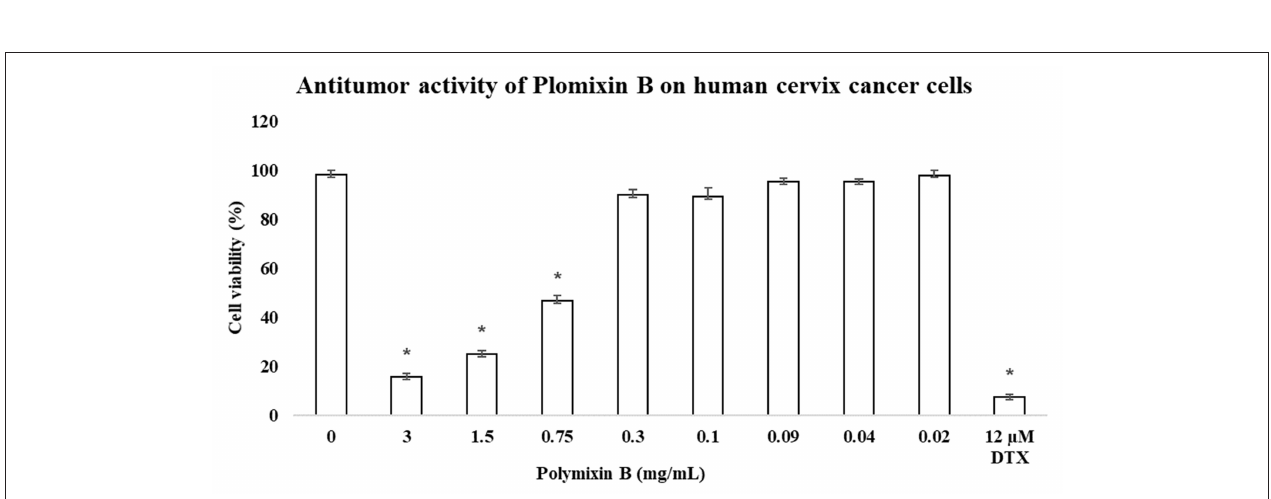
FIGURE 4 | Antitumor effect of polymyxin B on HeLa cell line. Cell viability ( via MTT assay) after a 24-h exposure to serial dilutions of polymyxin B and 12 µ M docetaxel (DTX) as positive control of cytotoxicity. Antitumor activity was significant and dose-dependent as of 0.75 mg/mL ( p < 0.0001). Asterisks indicate statistical differences ( α =